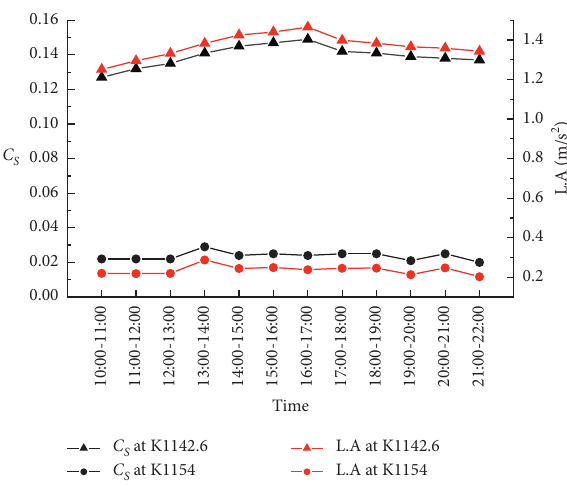
Figure 3: C S and lateral acceleration at K1142.6 and